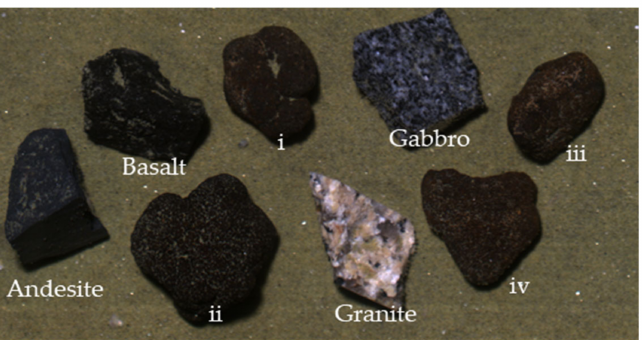
Figure 11. The pseudo-RGB (R:640 nm, G: 550 nm, B: 470 nm) image of the mineral samples. Numbers i to iv represent the manganese nodules in different